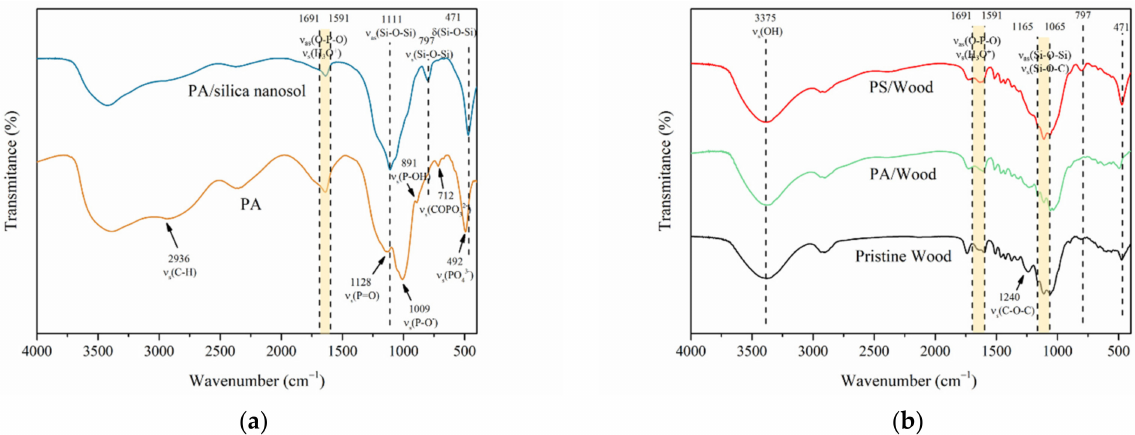
Figure 3. FTIR spectra of ( a ) pure PA, the prepared PA/silica nanosol after heat treatment at 80 ◦ C and ( b ) the wood